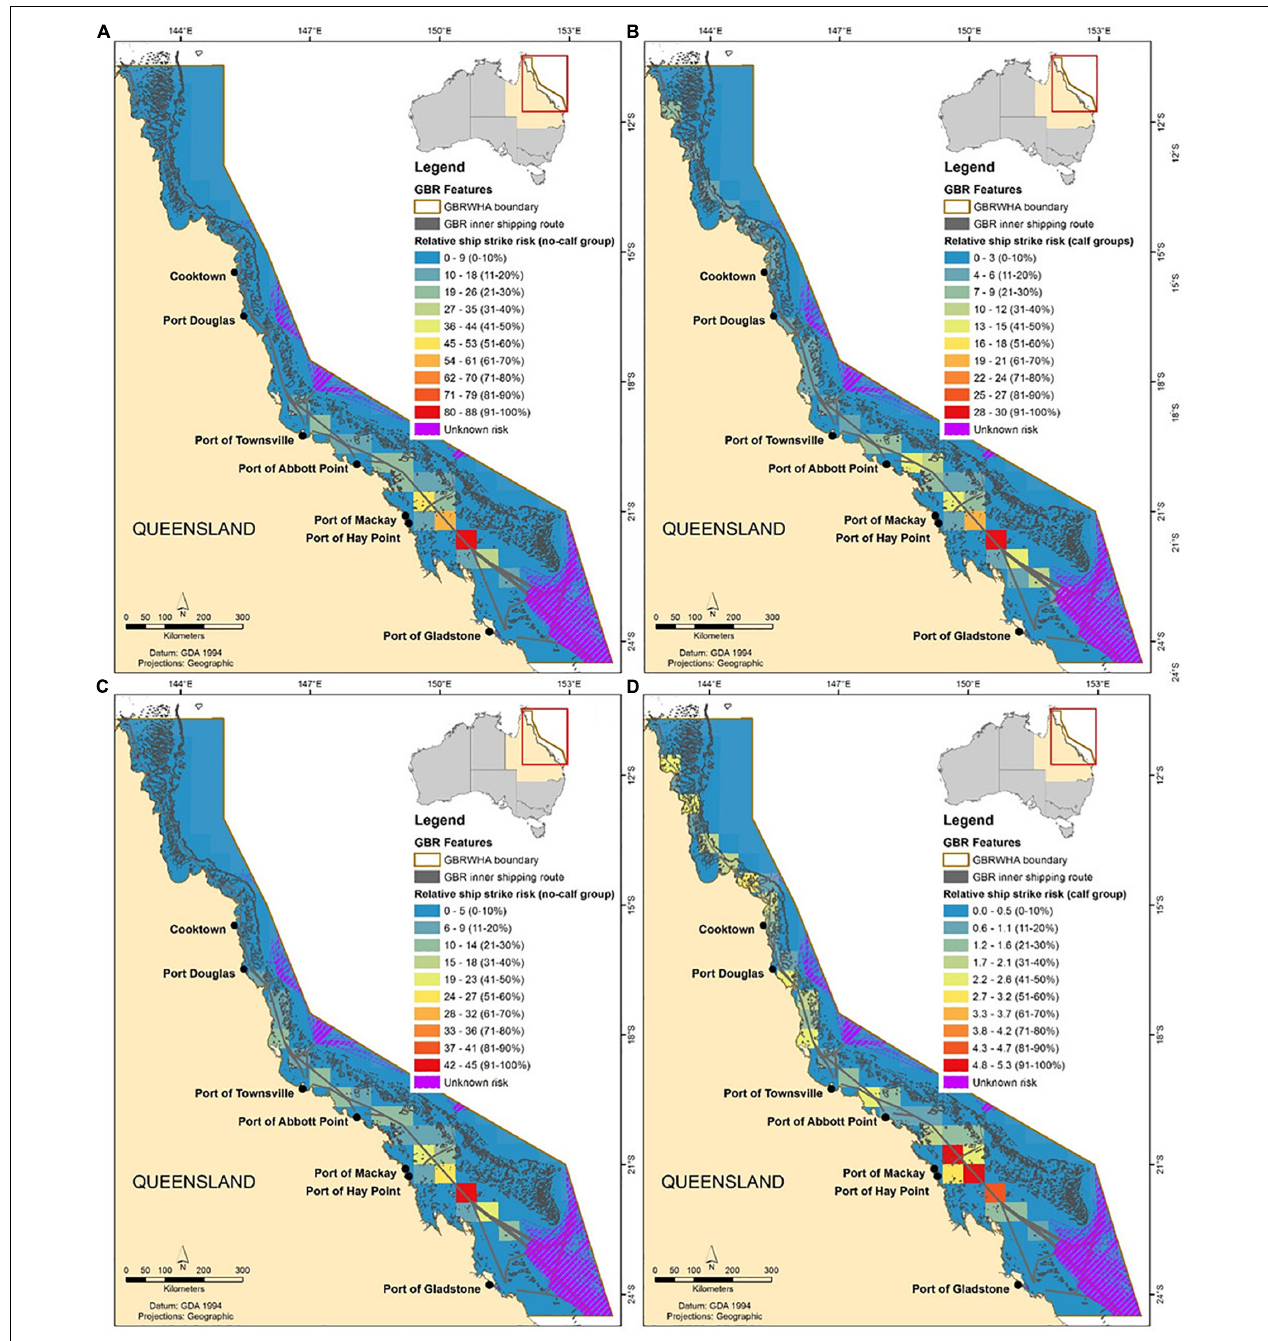
FIGURE 5 | Relative ship strike risk for humpback whale (A) non-calf groups and (B) calf groups in August 2012 and (C) non-calf groups and (D) calf groups in September 2014 based on 2016 ship data at a 50 × 50 km grid cell resolution.